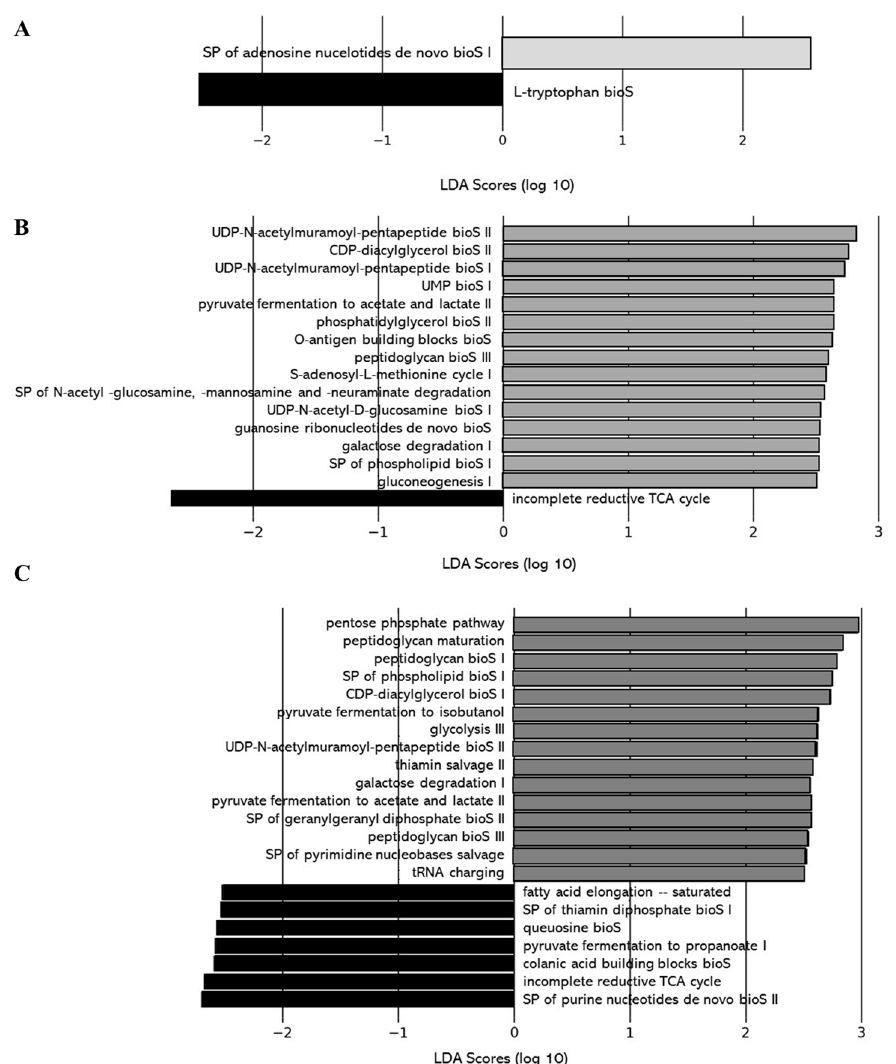
Figure 7. Level of deacidification of CJ is associated with altered metabolic pathways in the gut microbiota of mice. The linear discriminant analysis (LDA) effect size was calculated in order to explore the microbial functions that more strongly discriminated between the gut microbiota of mice treated with ( A ) 0% DCJ (dark) and 40% DCJ (light grey), ( B ) 0% DCJ and 60% DCJ (medium grey), and ( C ) 0% DCJ and 80% DCJ (dark grey). bioS: biosynthesis, SP: superpathway.